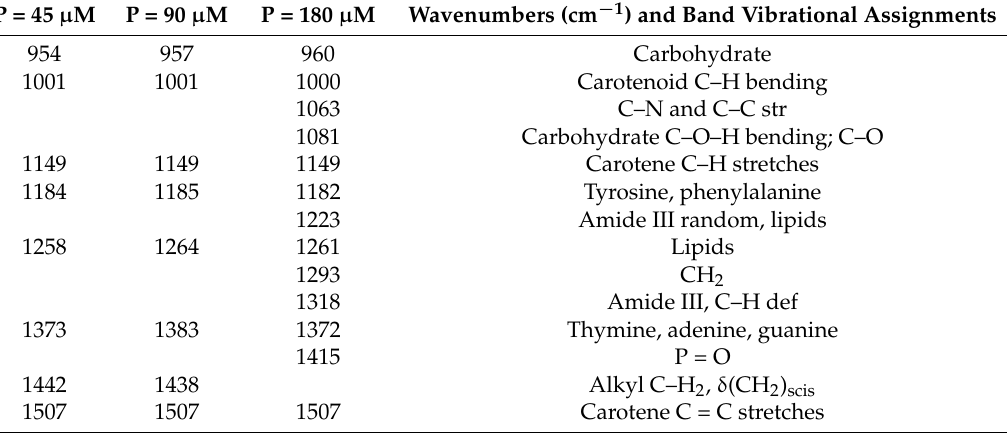
Table 3. Raman wavenumbers (cm − 1 ) and band vibrational assignments of TERS analysis of